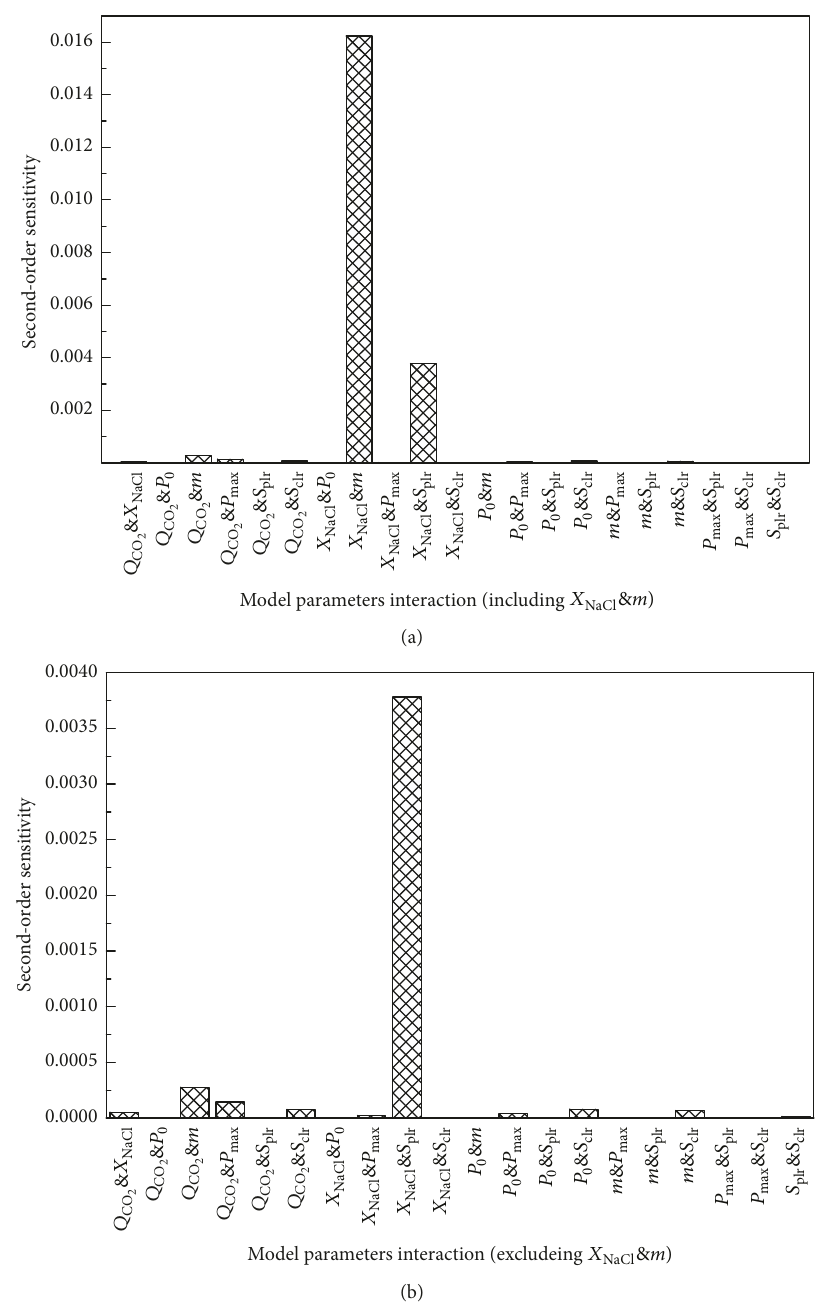
Figure 13: Second-order sensitivity coefficients of salt precipitate model ((a) contains all the parameter combinations, and (b) removes the most influential parameter combination ( 𝑋 and 𝑚 NaCl